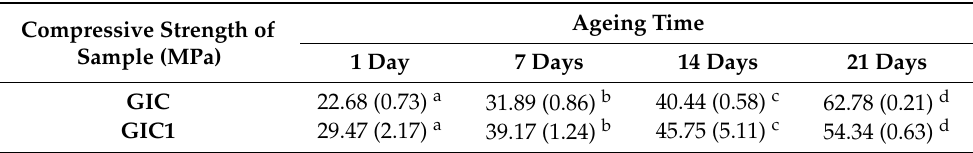
Figure 2. Compressive strength results of GIC and GIC1 samples at different ageing time (error bars indicate standard error). Table 2. Mean compressive strength along with standard deviation (SD) of GIC and GIC1 samples at different ageing